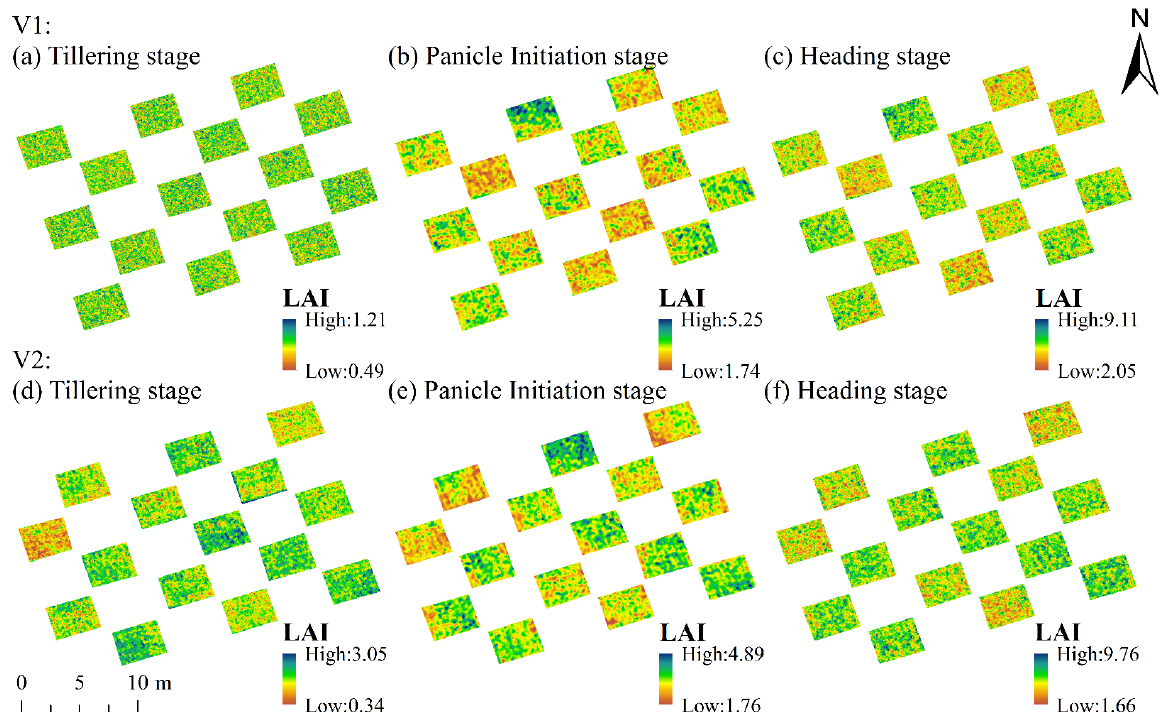
Figure 6. Rice leaf area index (LAI) maps of the study area. Variety V1 (Meixiangzhan 2) at ( a ) the tillering stage, ( b ) panicle initiation stage, and ( c ) heading stage; and variety V2 (Wufengyou 615) at ( d ) the tillering stage, ( e ) panicle initiation stage, and ( f ) heading stage.